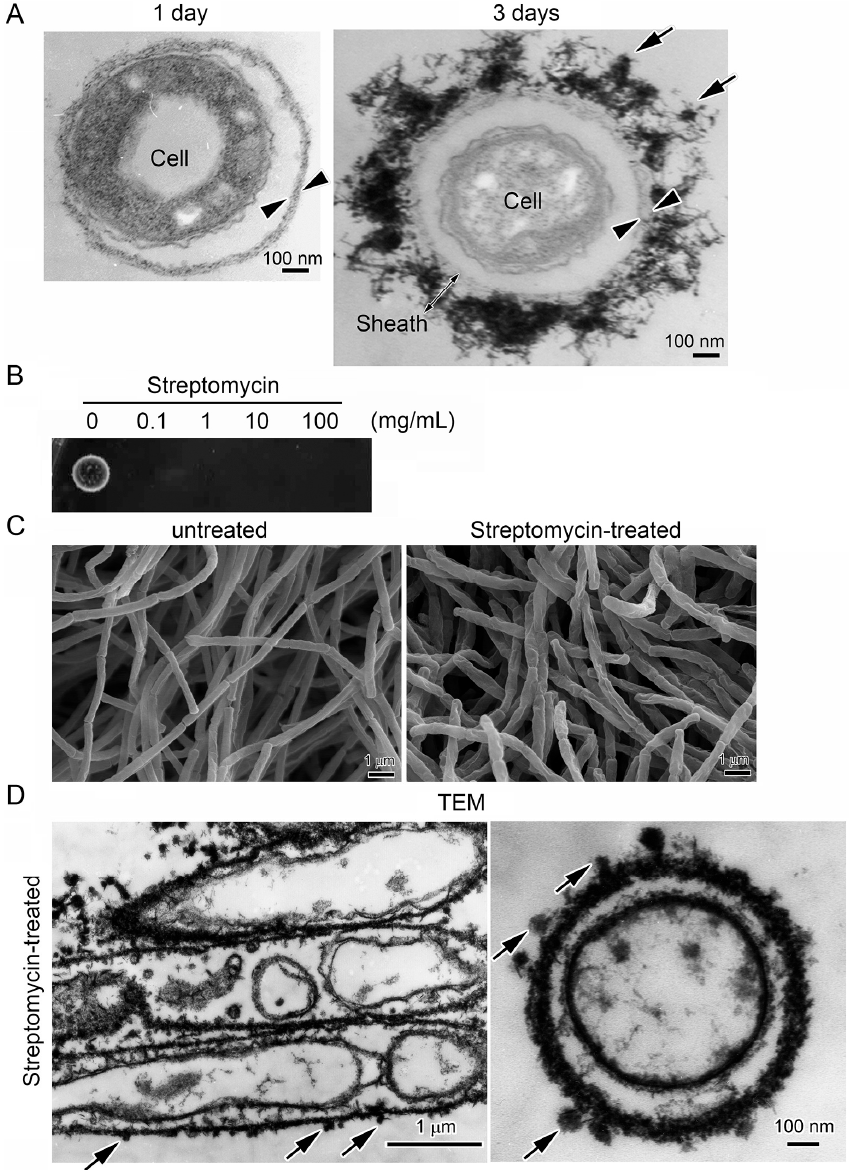
Figure 4. Adherence of electron-dense particles onto sheath remnants of streptomycin-killed cells ( A ) TEM images of sheaths after 1 day ( left ) and 3 days ( right ) of incubation in SGP + Fe. Arrowheads: thin primitive sheaths, arrows: electron-dense particles. Note that electron-dense particles only adhered to the loosely woven projections outside the thin primitive sheath ( right ); ( B ) Cells were sensitive to ≥ 0.1 mg/mL streptomycin (SM), as determined by a spot test on SGP agar; ( C ) SEM images of SM-treated sheaths ( right ) and untreated sheaths ( left ); ( D ) TEM images of SM-treated sheaths after 14 days incubation in SGP + Fe. Note the degenerated cytoplasm enveloped by distorted plasma membrane. Arrows indicate electron-dense particles that correspond to Fe(III) abiotically generated in the medium.